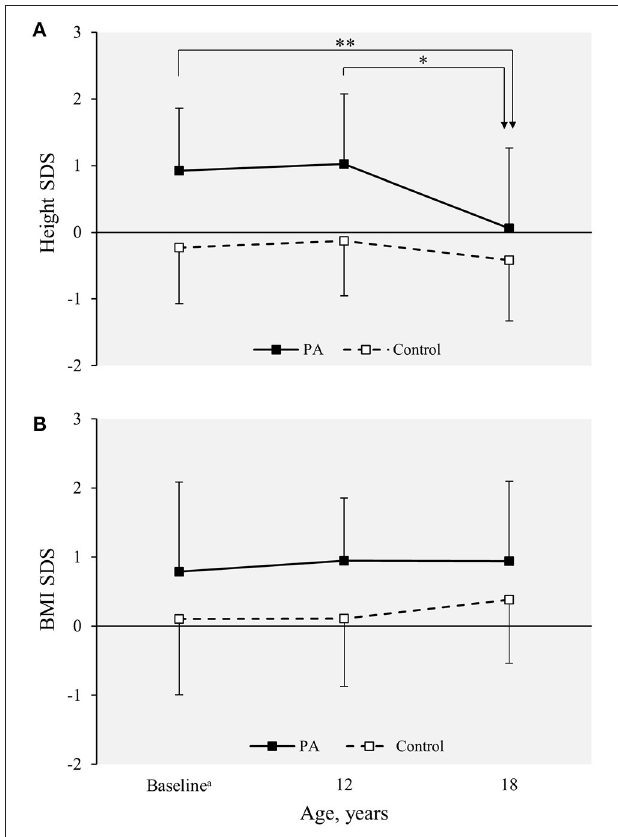
FIGURE 1 | (A) Height and (B) BMI SDS in the PA ( n = 30 at baseline and adulthood; n = 17 at the age of 12 years) and control females ( n = 42 at baseline and adulthood; n = 30 at the age of 12 years) from prepuberty to adulthood. Values are expressed as mean (standard deviation). Statistical significance of the age-dependent changes within each group were analyzed using the paired samples t -test. ** p < 0.001; * p < 0.01. BMI, body mass index; PA, premature adrenarche; SDS, standard deviation score.